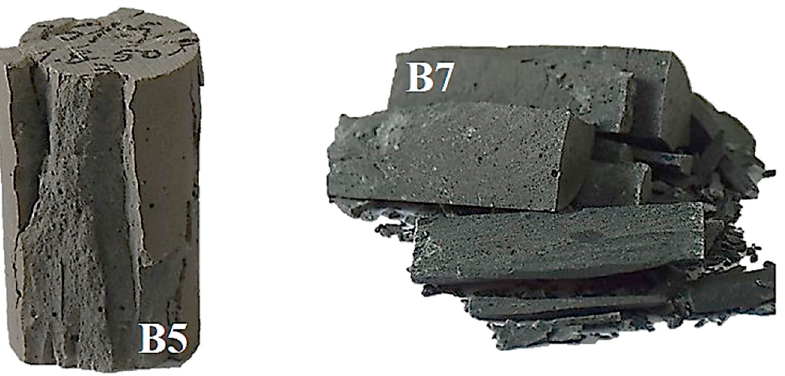
Figure 15. Comparison of the fracture state of B5 and B7 of AA-FASM after compressive strength.